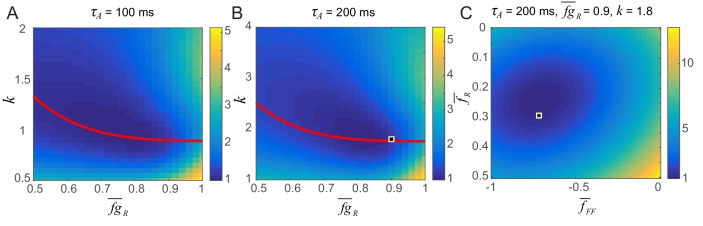
Parameter search for the strengths of potentiation and adaptation (A,B) and average post-synaptic dependence of recurrent and feedforward connections, f¯R, and f¯F (C).The color map shows the distance between the data and simulation of the response for familiar stimuli normalized by the lowest distance. The red curve in A and B shows the pairs of fg¯R and k that provide the damped oscillation with its period around 150 ms and provide a good fit to the data. In Figure 5, we chose (fg¯R,k) = (0.9,1.8) (the square in B) and (f¯R,f¯F) = (0.3,–0.7) (the square in C) for τA = 200 ms which gives a good fit to a data in a dimming detection task (Figure 5B) as well as generating strong resonance behavior in the successive stimulus presentation (Figure 5D). The distance between the data and simulation is obtained by comparing them between 0 and 300 ms after the activity onset except between 50 ms and 100 ms due to the rapid decrease of activity between 50 and 100 ms which cannot be captured by the simulation.